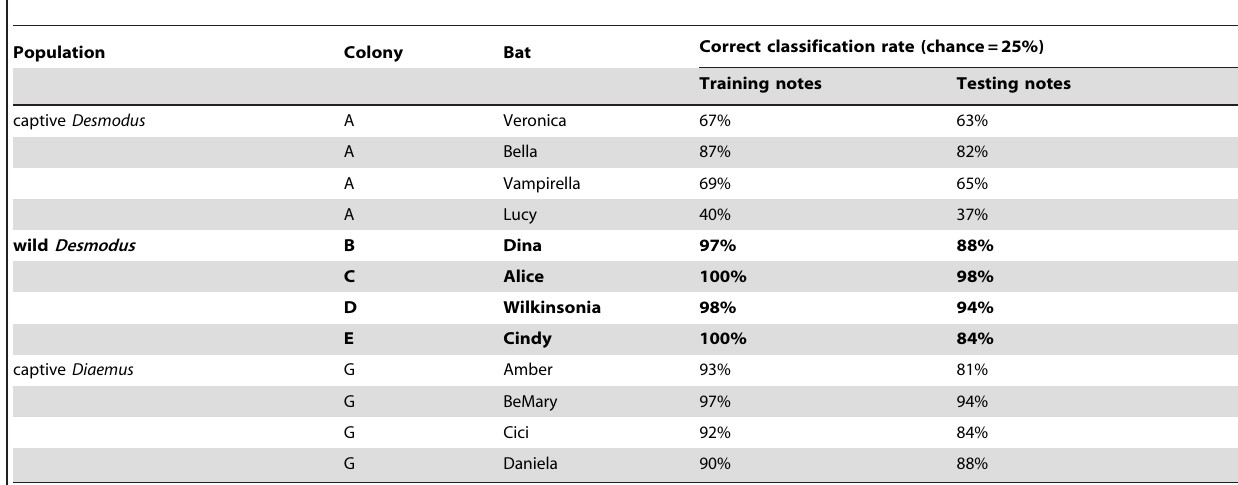
Table 4. Percentage of correctly assigning notes to four individuals for captive and wild common vampires Desmodus rotundus and captive white-winged vampires Diaemus youngi